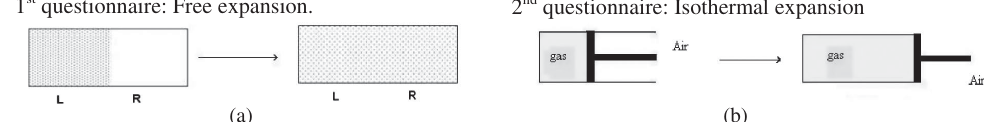
FIG. 4. (a) Free expansion of an ideal gas. (b) Isothermal expansion of an ideal